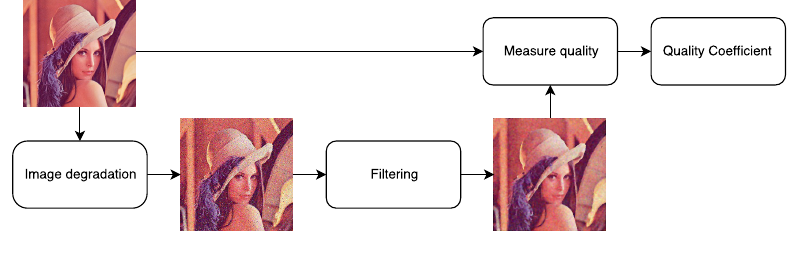
Figure 4. Standard approach to quality image